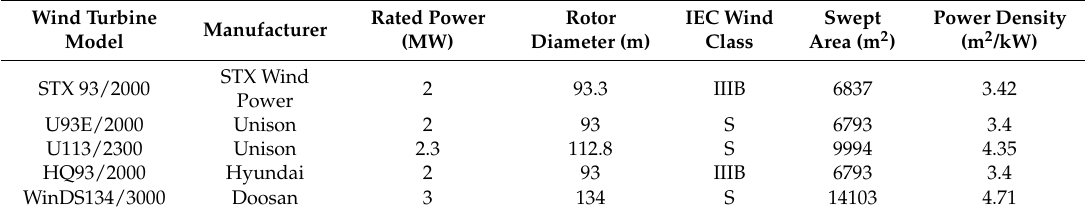
Table 6. Characteristics of selected wind turbines for Deokjeok-do and Baengnyeong-do.